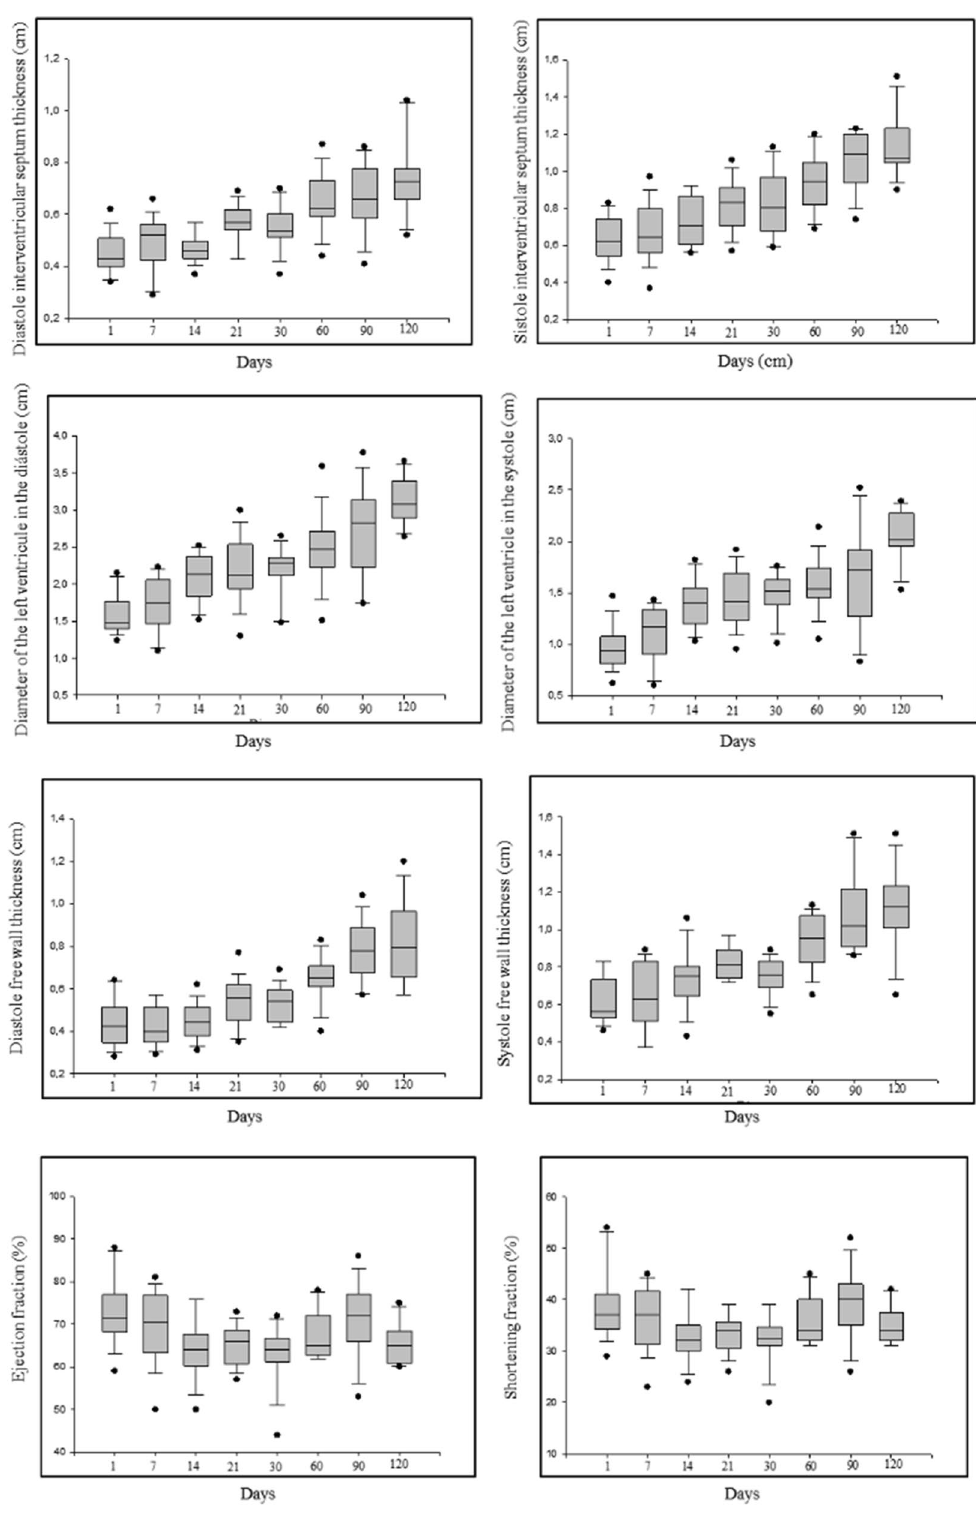
Figure 2. Echocardiographic parameters during the neonatal period up to 120 days of age in Dorper